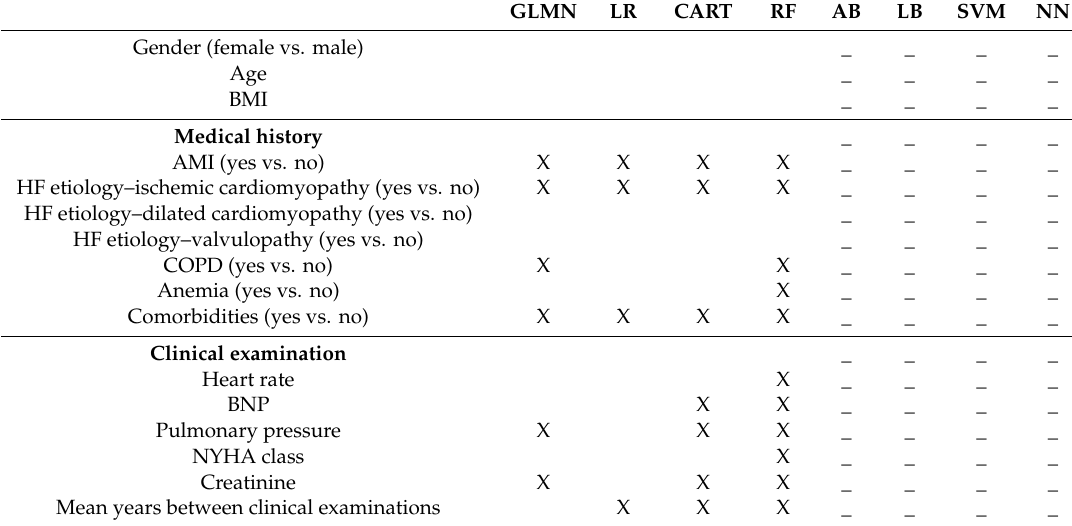
Table 7. Su ff ering from comorbidities, higher levels of creatinine and pulmonary pressure, and had su ff ered from AMI and ischemic cardiomyopathy were found to be significantly associated with a higher risk of hospitalization. Table 6. Covariates identified by the MLTs trained with CC to have predictive value in identifying patients that had a hospitalization. The symbol “X” denotes that the covariate had predictive value, whereas an empty cell denotes that the covariate had no predictive value. The symbol “_” was used for the MLTs for which it was not possible to identify covariates that had a predictive impact.